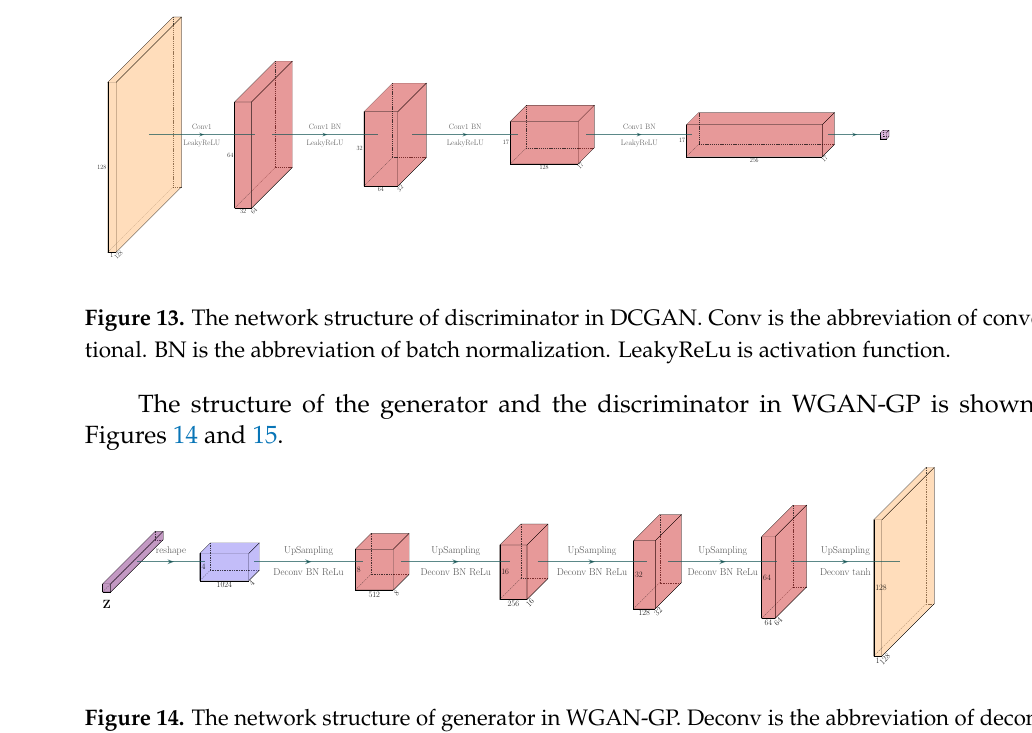
Figure 14. The network structure of generator in WGAN-GP. Deconv is the abbreviation of deconvo- lutions. BN is the abbreviation of batch normalization. Relu is activation function.